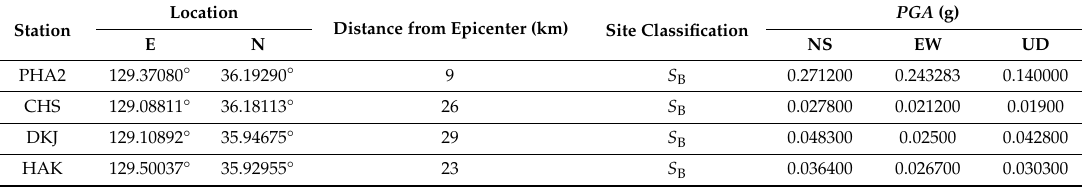
Table 2. Information of the four recording